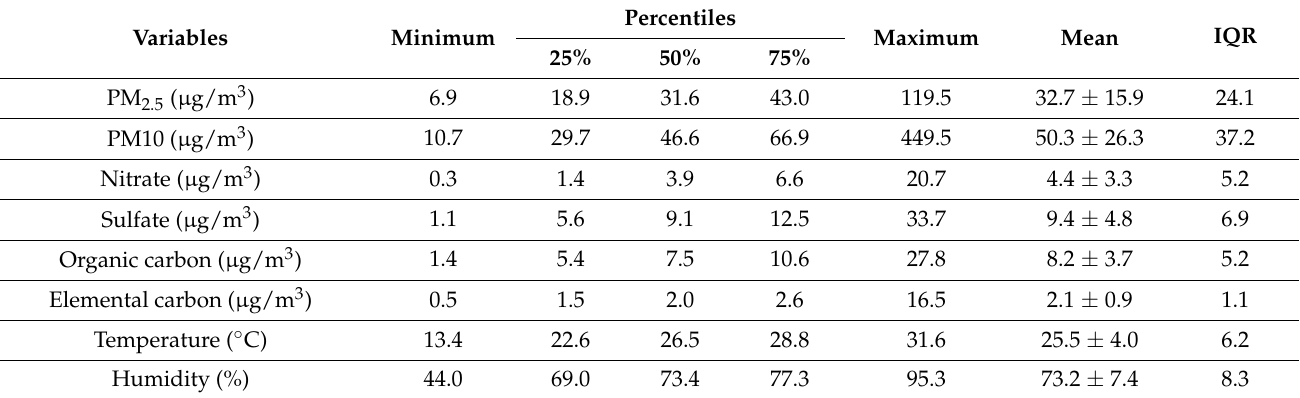
Table 2. Summary statistics for meteorology and air pollution in Kaohsiung,